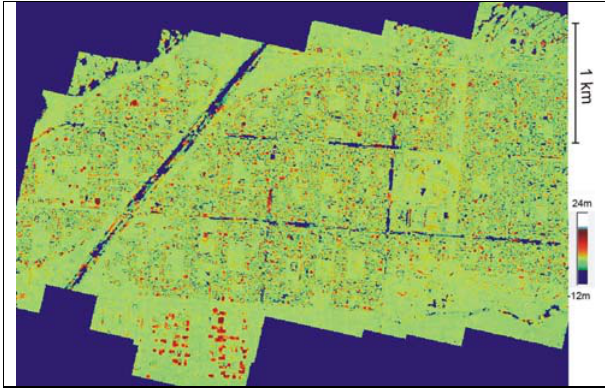
Figure 36: DSM differences – GeoEye-1 minus IKONOS based on LSM, whole project